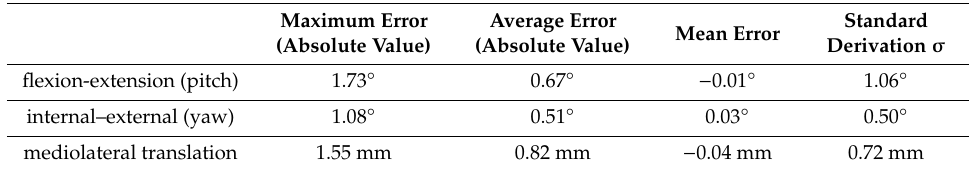
Table 2. Pose Reconstruction Errors.